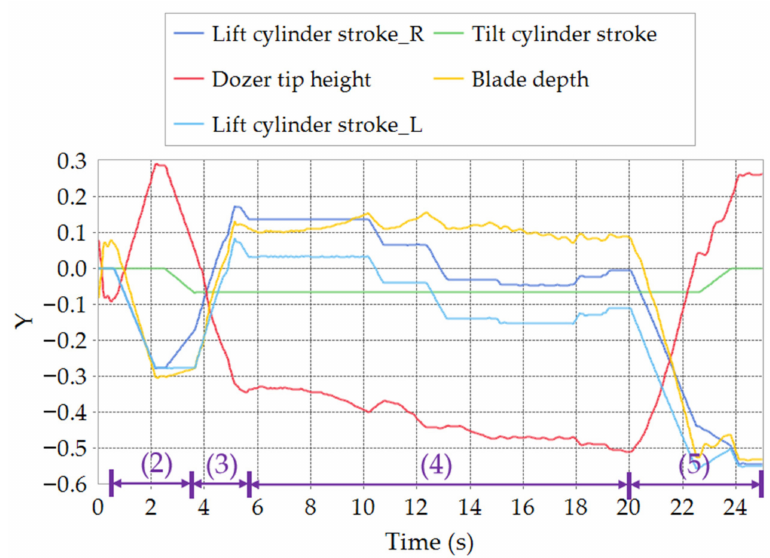
Figure 5. Cylinder strokes and blade heights.